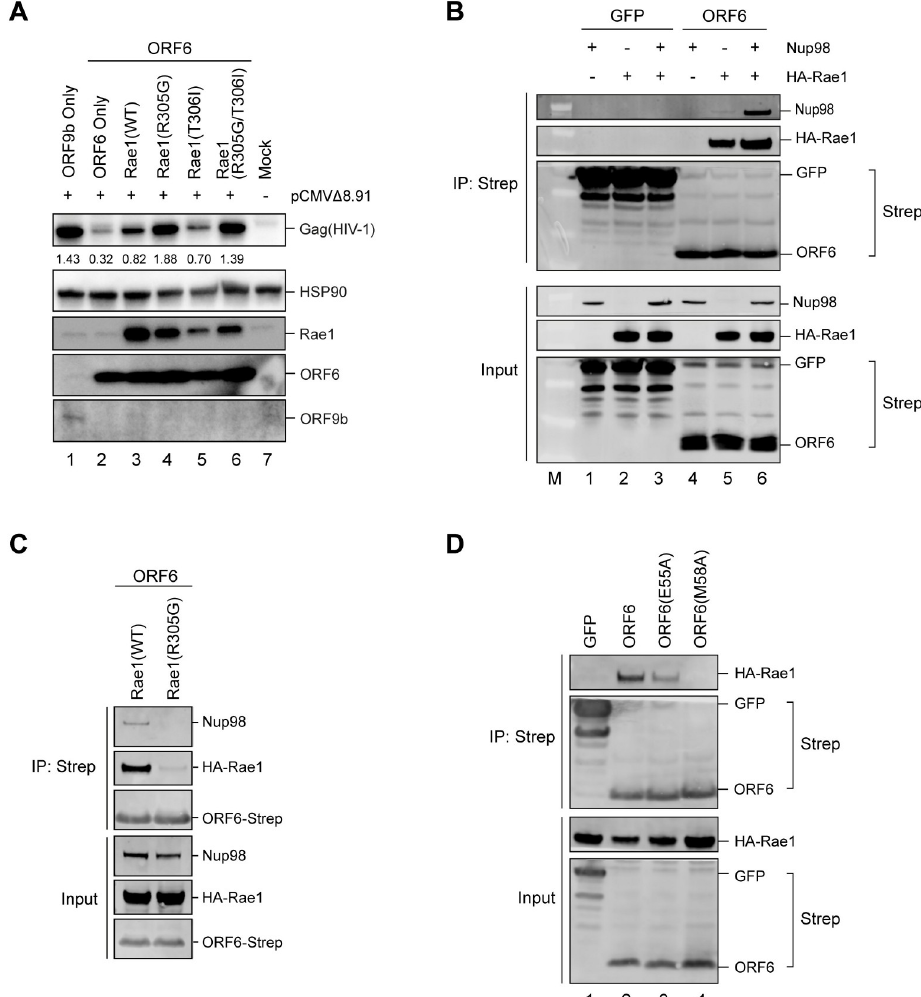
Fig 2. ORF6 inhibits protein expression by interfering with Rae1. (A) HEK293T cells were co-transfected with plasmids encoding HIV-1 Gag-Pol, ORF6 or ORF9b and Rae1 or indicated Rae1 mutant. Mock cells were untransfected. After 48h, cell lysates were separated by SDS-PAGE and analysed for Gag(HIV-1), Rae1, ORF6 or ORF9b and HSP90 by immunoblotting. Gag expression was quantified, normalised to HSP90, and shown in numbers below the Gag panel. (B) HEK293T cells were transfected with plasmids encoding Twin-Strep-tagged GFP or ORF6 and Nup98 and/or HA-Rae1. After 24h, Twin-Strep-tagged proteins were immunoprecipitated with MagStrep beads and proteins eluted with biotin. Input lysates and eluate were separated by SDS-PAGE and analysed by immunoblotting for Strep, Nup98 and HA. (C) HEK293T cells were transfected with plasmids encoding Twin-Strep- tagged GFP or ORF6, Nup98 and either HA-Rae1(WT) or HA-Rae1(R305G). After 24h, Twin-Strep-tagged proteins were immunoprecipitated and analysed as in (C). (D) HEK293T cells were transfected with plasmids encoding Twin- Strep-tagged proteins; ORF6(CoV-2), ORF6(E55A), ORF6(M58A) or GFP and HA-Rae1(WT). After 24h, Twin-Strep- tagged proteins were immunoprecipitated with MagStep beads and input lysates and eluates separated by SDS-PAGE and analysed by immunoblotting for Strep and